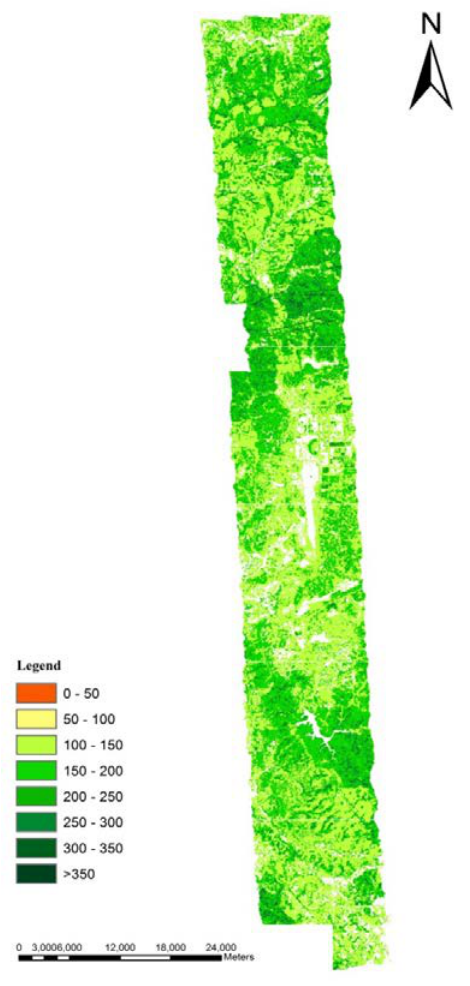
Figure 4. Forest AGB mapping in Puer, Southwest